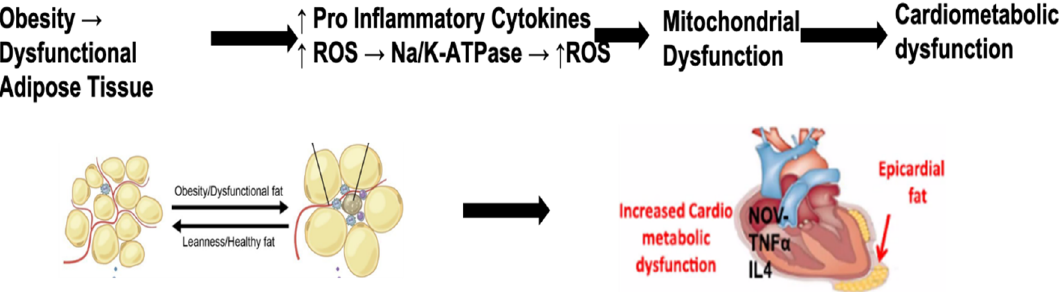
Figure 10. Schematic depicts a pathway leading to obesity induced cardiometabolic dysfunction. This pathway is further exacerbated by COVID-19 infection.